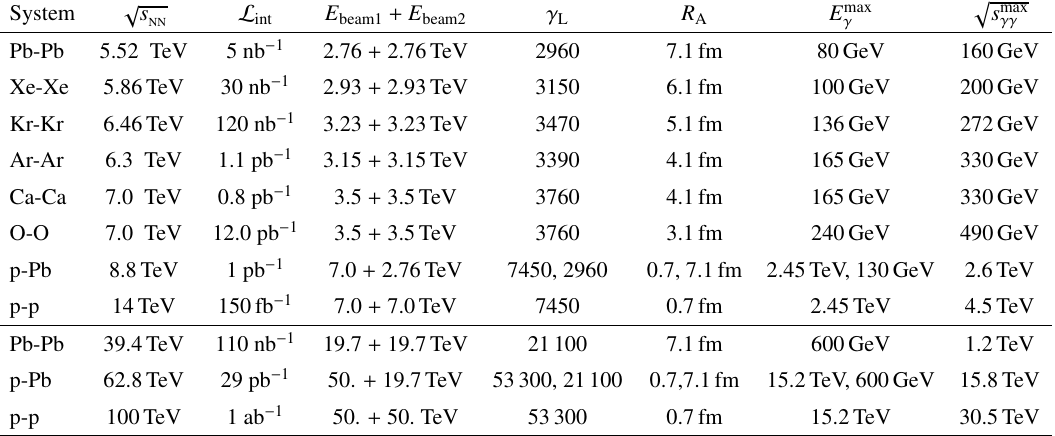
Table 2 . Summary of the generic characteristics of photon-photon collisions in ultraperipheral proton and nuclear collisions at HL-LHC [33, 35] and FCC [69, 70] energies. For each colliding system, we quote its (i) p s nucleon-nucleon (NN) c.m. energy , (ii) integrated luminosity per typical run L int , (iii) beam energies NN E beam , (iv) Lorentz factor (cid:13) L , (v) e (cid:11) ective charge radius R A , (vi) photon “maximum” energy E max